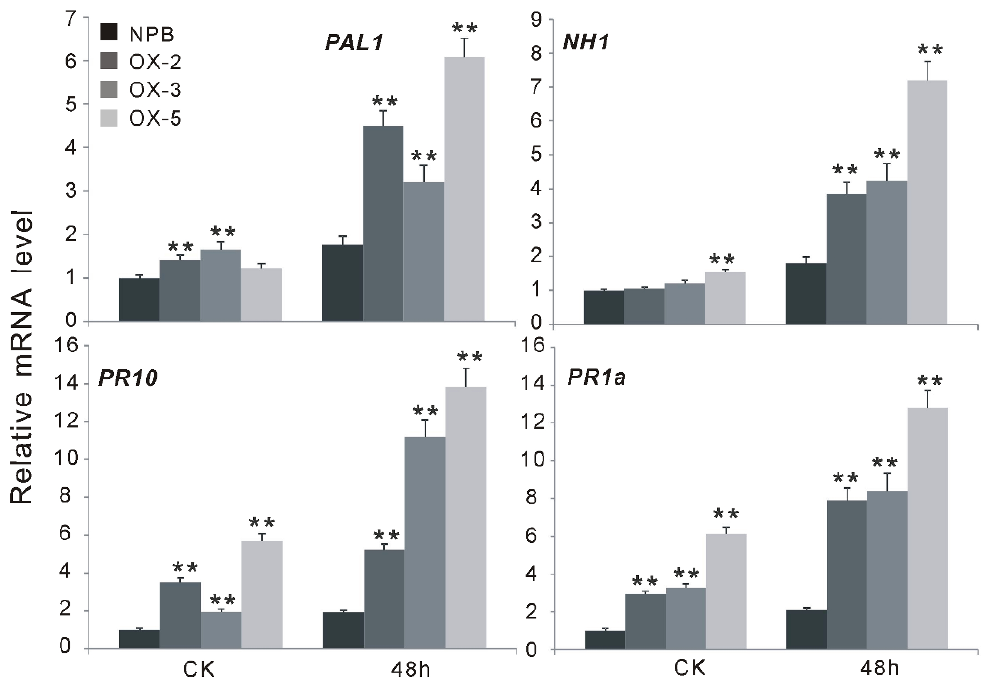
Figure 4. The expression changes of the genes associated with the salicylic acid (SA) signaling pathway before and after blast infection. Overexpression of OsGF14f significantly induced the expression of SA responsive genes and the SA synthesis-related genes. ** p < 0.01.